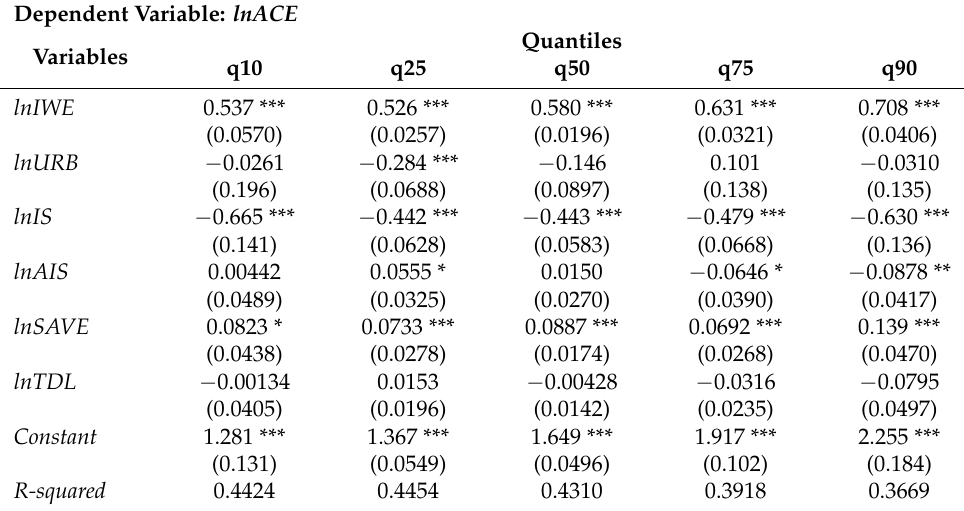
Table 5. Estimation of two-step panel quantile